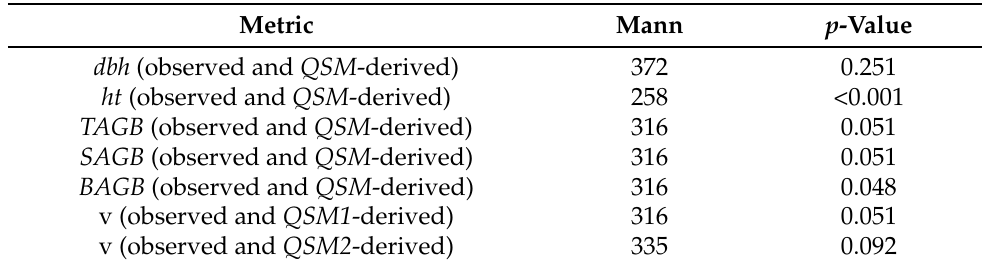
Figure 4. Relationship between QSM-derived and field-based diameter at breast height (dbh) ( a ) and total tree height (ht) ( b ), where observed data are measured in the field. Table 2. Mann–Whitney test (95% probability) for QSM-derived tree dbh, total height (ht), volume (v), and biomass (TAGB, SAGB, and